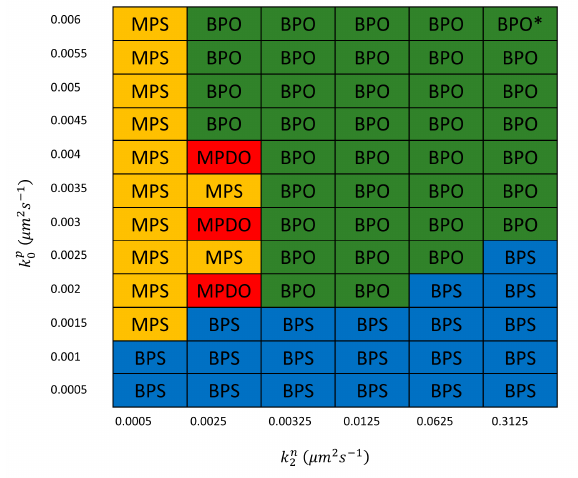
Figure 4. Structure of dynamical states reached, as function of a positive ( 𝑘 (cid:2868)(cid:3043) ) and negative ( 𝑘 (cid:2870)(cid:3041) ) feedback rate constants. Results show the final state reached by a single simulation for each set of parameters over time course of 800–1200 s, starting from an unpolarized state. In state marked with *, the Cdc42-GTP patch regions becomes as small as a single Voronoi region of the discretized cell surface. Other parameters same as Table 1.